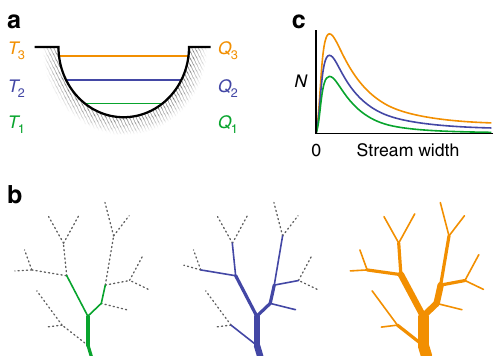
Fig. 5 Conceptual model of relationship between changing stream fl ow conditions and the stream width distributions. As discharge increases ( Q 1 < Q 2 < Q 3 ): a wetted width increases at a representative channel cross section; b the ADN extends into narrower lower-order channels, increasing the total length of narrow streams (dotted lines represent channels without fl ow); and c the phenomena described by a and b manifest in the similar width distributions independent of stream fl ow